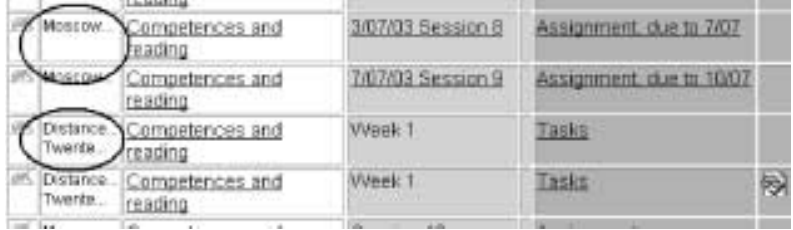
Figure 4. Roster in which two groups (Moscow and Distance students Twente) were distinguished